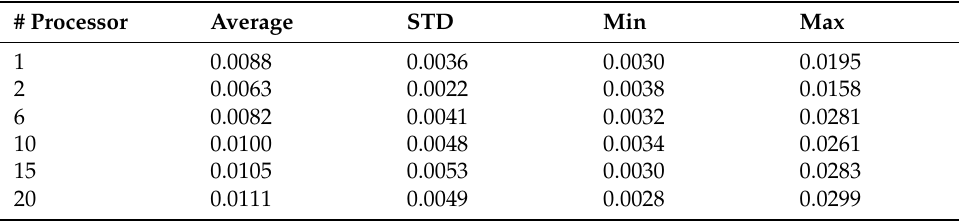
Table 4. SM statistics of Pareto solutions for different scenarios.